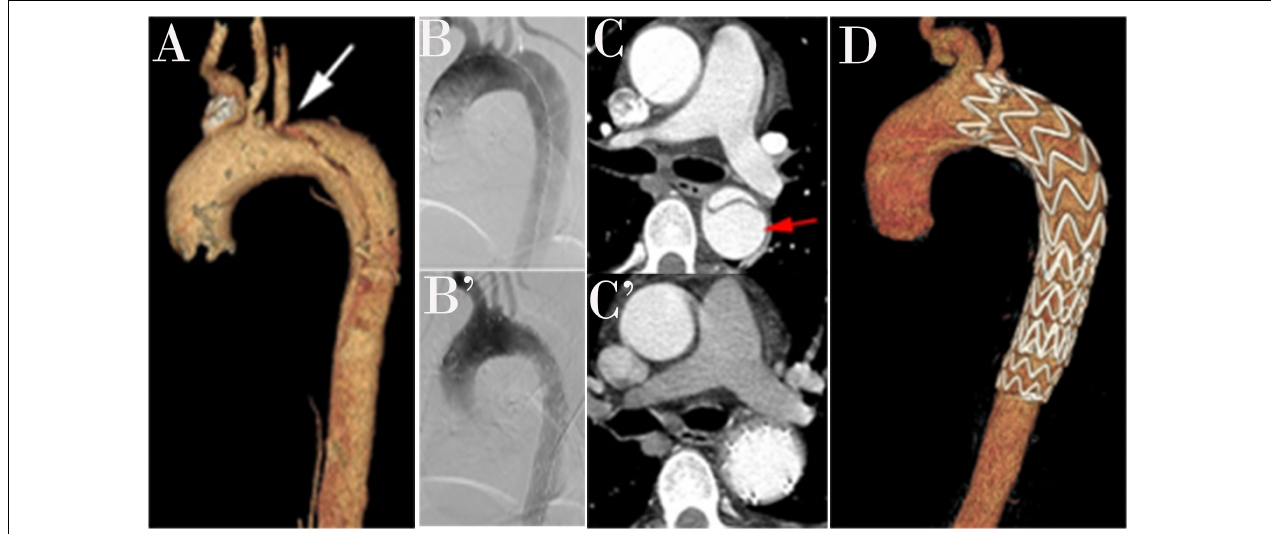
FIGURE 3 | A three-dimensional computed tomography angiography (CTA) is shown in a patient with type B aortic dissection (TBAD; A ). An intraoperative angiogram demonstrates TBAD (B) . A Post-operative angiogram after thoracic endovascular aortic repair (TEVAR; B’ ). Preoperative view with a patent false lumen (C) . False lumen obliteration after TEVAR (C’) . Completion angiogram after successful repair of TBAD shows the coverage of primary entry and no evidence of endoleak (D)